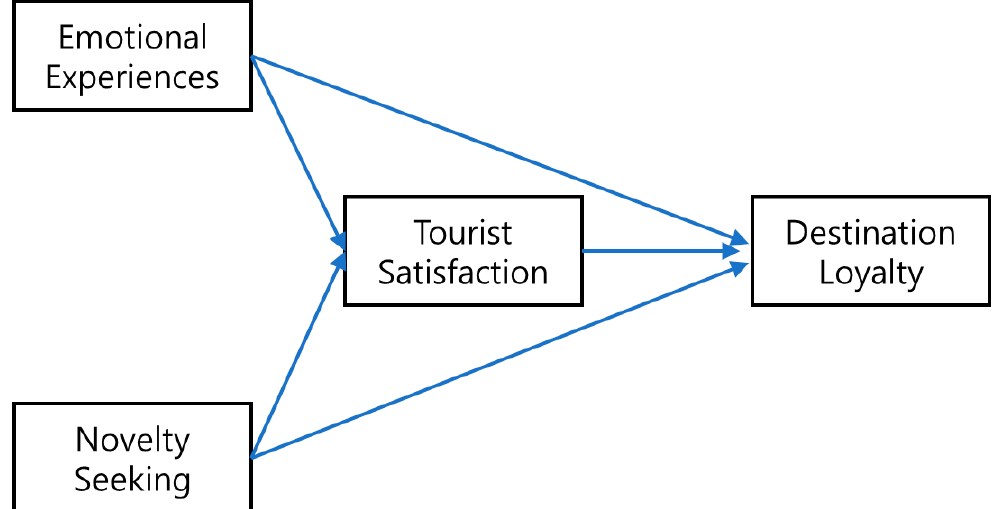
Figure 2. The proposed conceptual model. Source: author’s compilation.